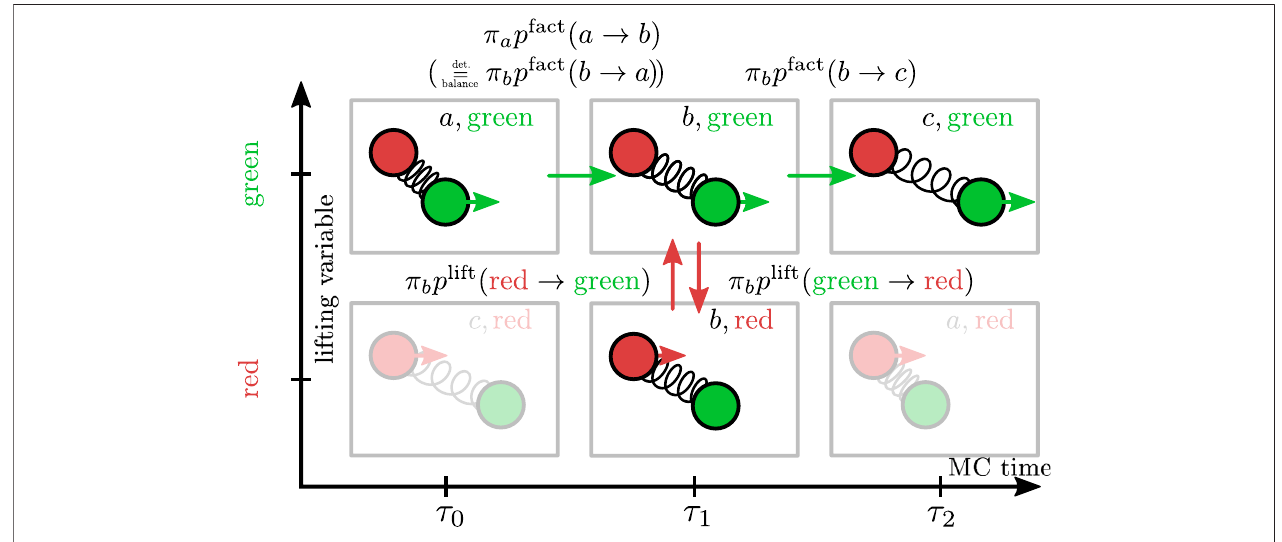
FIGURE3| Schemeoftheliftingformalismforacontinuouspairinteraction(notationsee Figure2 ).Using Eq.5 intheglobalbalancecondition (3) forincomingand outgoing currents for state b and dividing by π b yields p lift ( red → green ) − [ d E b → c ] + (cid:2) p lift ( green → red ) − [ d E b → a ] , where d E b → c (cid:2) − d E b → a ≡ d E because of translational invariance. [ d E ] + (cid:2) 0 leads to p lift ( red → green ) (cid:2) 0, yielding p lift ( green → red ) (cid:2) [− d E ] + and vice versa, which assures maximal global balance. Detailed balance for physical transitions (green) ensures time reversibility, so that a reversed EC would redo the original one, while an EC itself satis fi es maximal global balance. For clarity we completed the lower row to show translational symmetry.